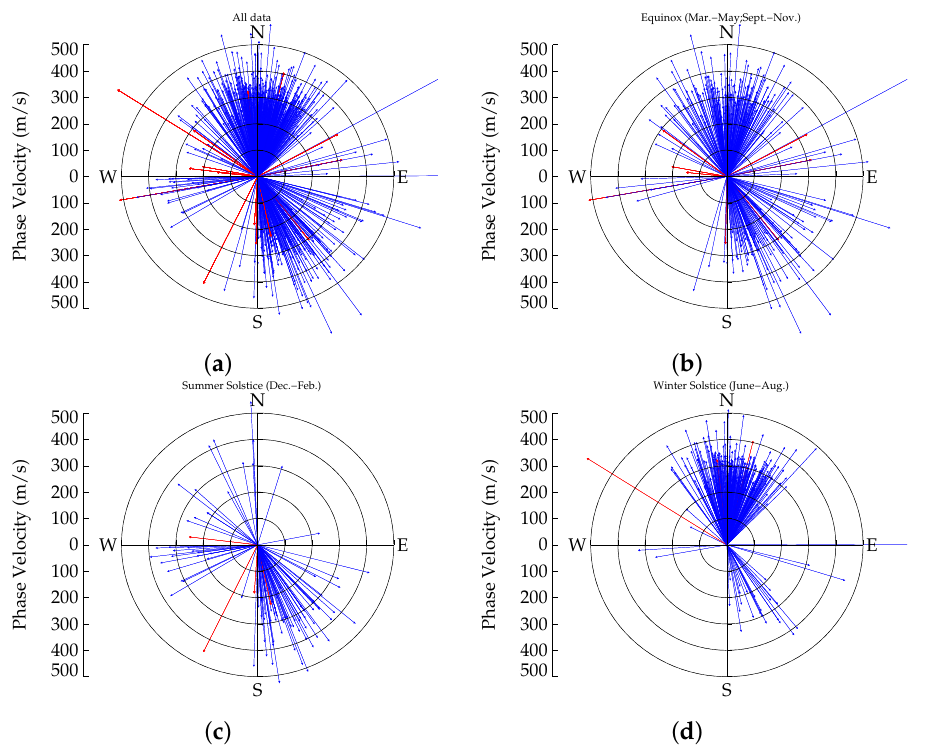
Figure 10. The propagation direction of the observed medium-scale traveling ionospheric distur- bances for ( a ) all seasons, ( b ) equinoxes, ( c ) summer, and ( d ) winter. The red arrows indicate the nighttime MSTID events while that of the blue are daytime and